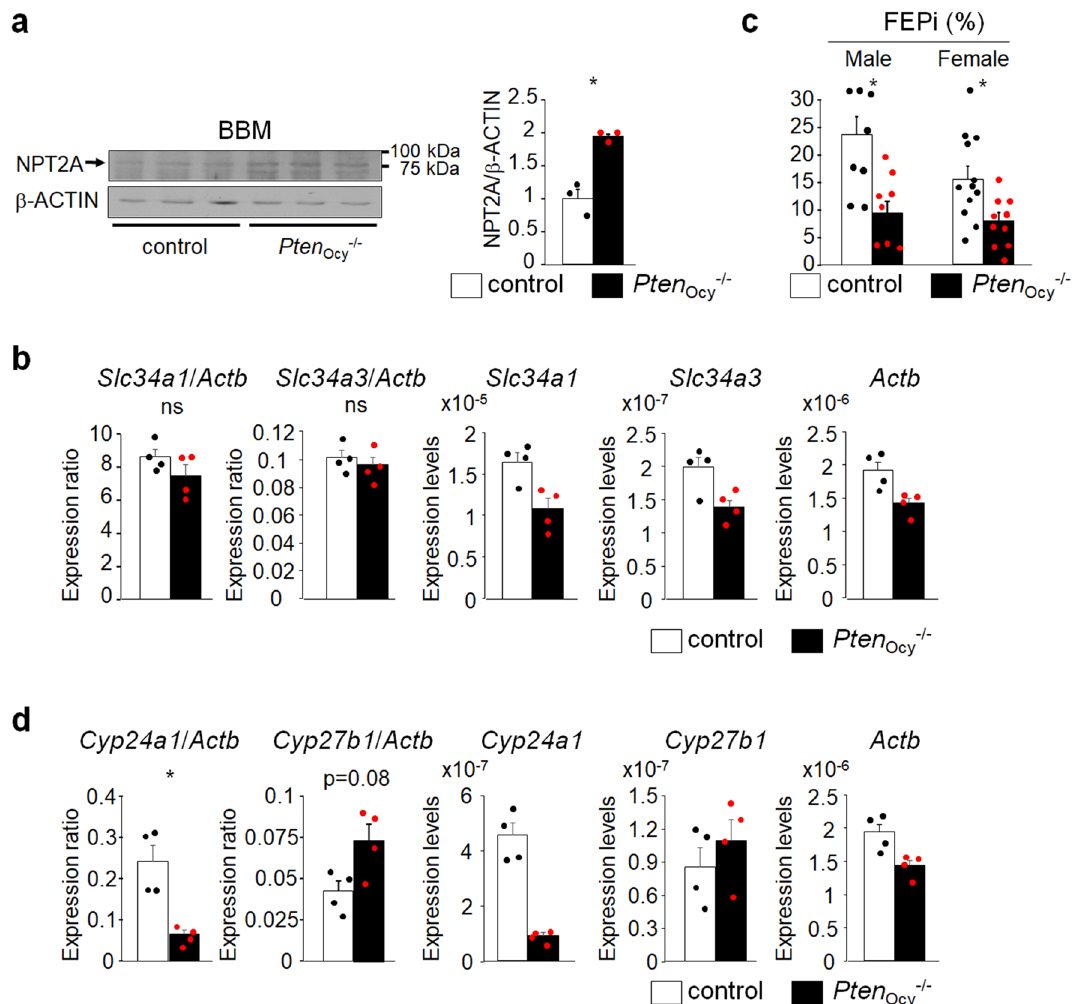
Figure 3. Enhanced Pi excretion in the urine of Pten Ocy −/− mice. ( a ) The brush border membrane of the kidney was isolated from 16-week-old male mice and the expression of NPT2A was assessed by a Western blot analysis (N = 3). A densitometric analysis was performed (N = 3). ( b ) Total RNA was extracted from 16-week-old male mice and the expression of Slc34a1 , Slc34a3 and Actb in the kidney was assessed by real time RT-PCR (N = 4), and the expression ratio of Slc34a1 / Actb and Slc34a3 / Actb was determined. Statistical analysis was performed after corrected for the expression of Actb . ( c ) The fraction excretion of Pi was measured in 16-week-old mice (male: N = 8, female: N = 10–12). ( d ) Total RNA was extracted from 16-week-old male mice and the expression of Cyp24a1 , Cyp27b1 and Actb in the kidney was assessed by real time RT-PCR (N = 4), and the expression ratio of Cyp24a1 / Actb and Cyp27b1 / Actb was determined. Statistical analysis was performed after corrected for the expression of Actb . Statistical analysis was performed by Mann–Whitney U test. * p < 0.05, ns: not significantly